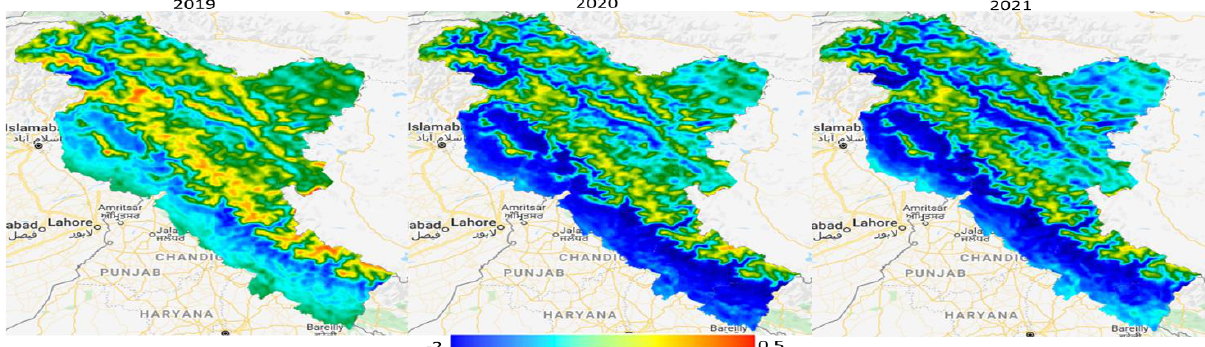
Figure 4 indicates highest concentrations of aerosols in 2019 and the lowest in 2020. Positive UV AI are observed in the mountainous regions of Ladakh, Jammu and Kashmir. Negative UV AI are observed in the lower elevations of Jammu and Kashmir, Himachal Pradesh and Uttarakhand. Negative UV AI are highest in 2020 in the lower elevations of Jammu and Kashmir, Himachal Pradesh and